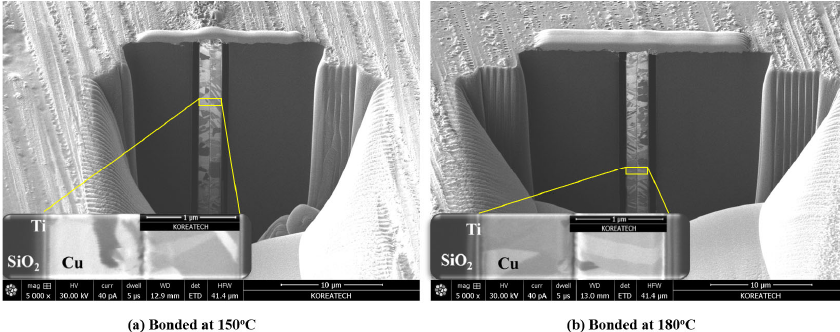
Figure 4. FIB-SEM cross-sectional images of Cu/Ag-Ag/Cu bonded Figure 4. FIB ‐ SEM cross ‐ sectional images of Cu/Ag ‐ Ag/Cu bonded samples.